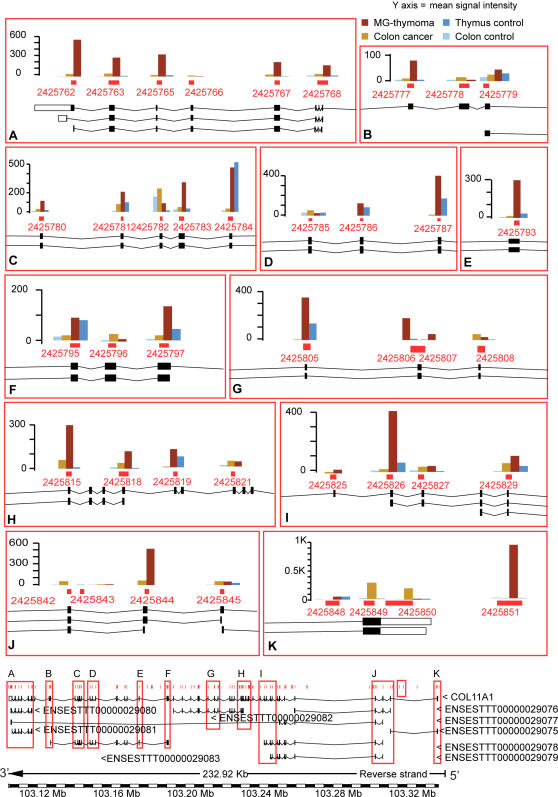
Detailed expression map of COL11A1 in MG-thymoma and colon cancer.The known transcript variant of COL11A1 (adopted from ENSEMBL [7]) is shown. Additional ENSEMBL EST-based transcripts [6] of COL11A1 are shown below it. The gene was up-regulated in MG-thymoma compared to both healthy thymus, colon cancer and healthy colon (A-J). An evidence for alternative start site in the thymus is apparent (K).